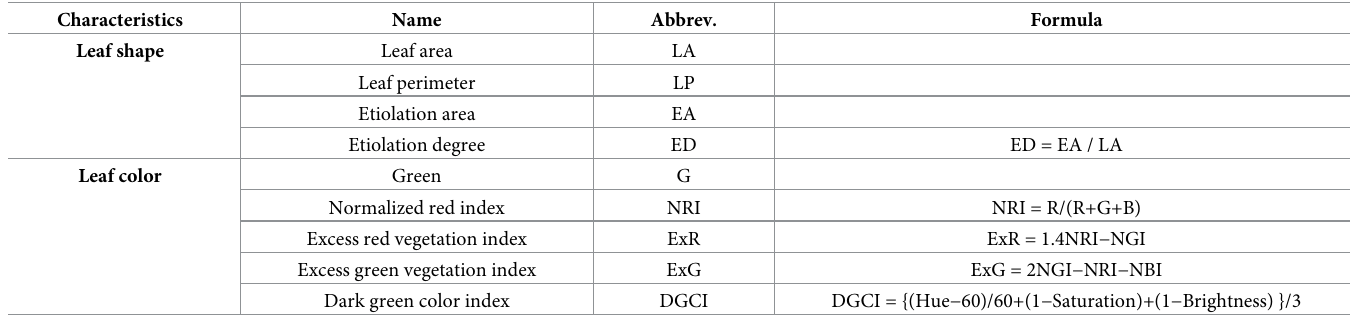
Table 1. Formula and explanation of different characteristics. Characteristics Name